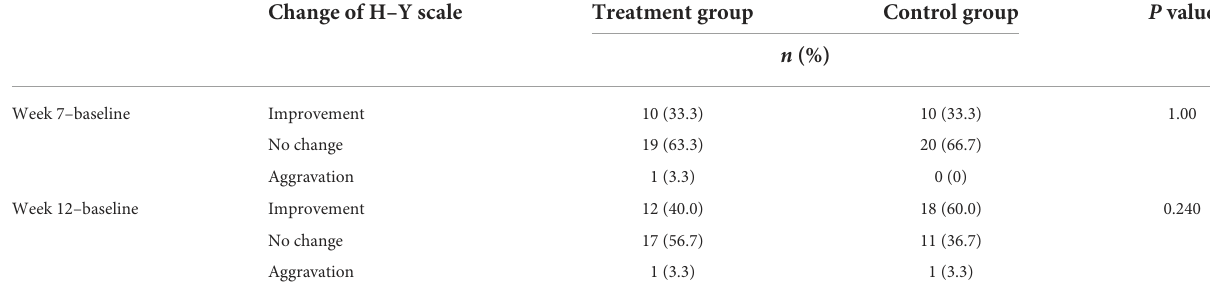
TABLE 6 Comparison of H–Y scale improvement rates between